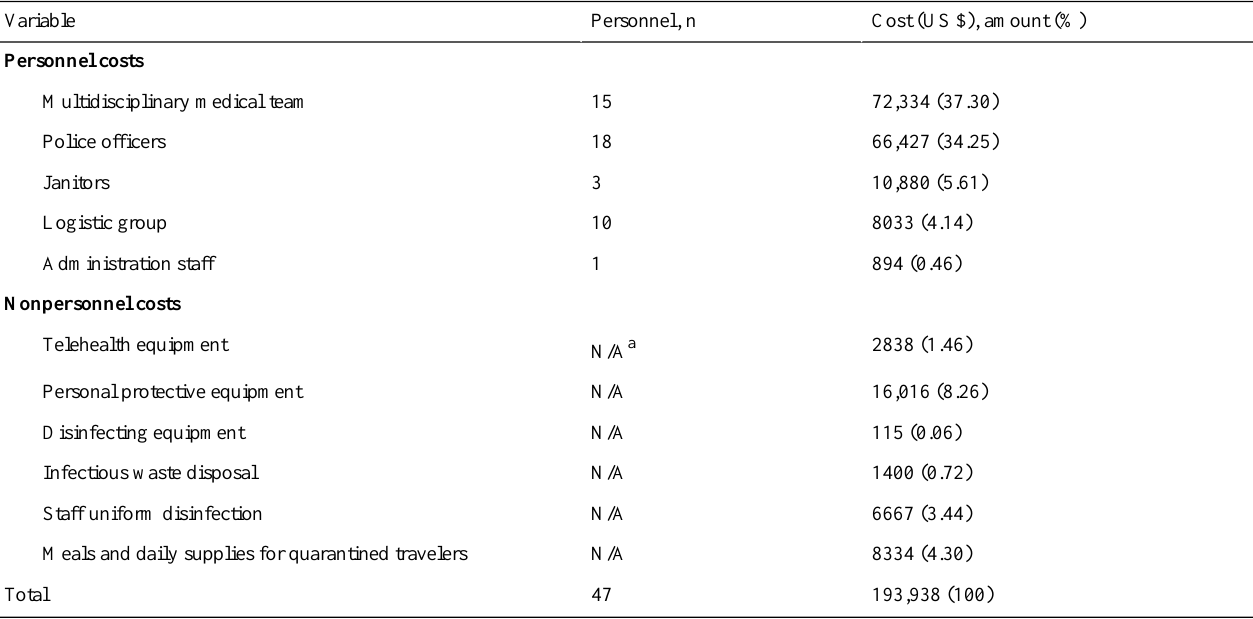
Table 2. Cost analysis of the 14-day mandatory quarantine of 217 Taiwanese